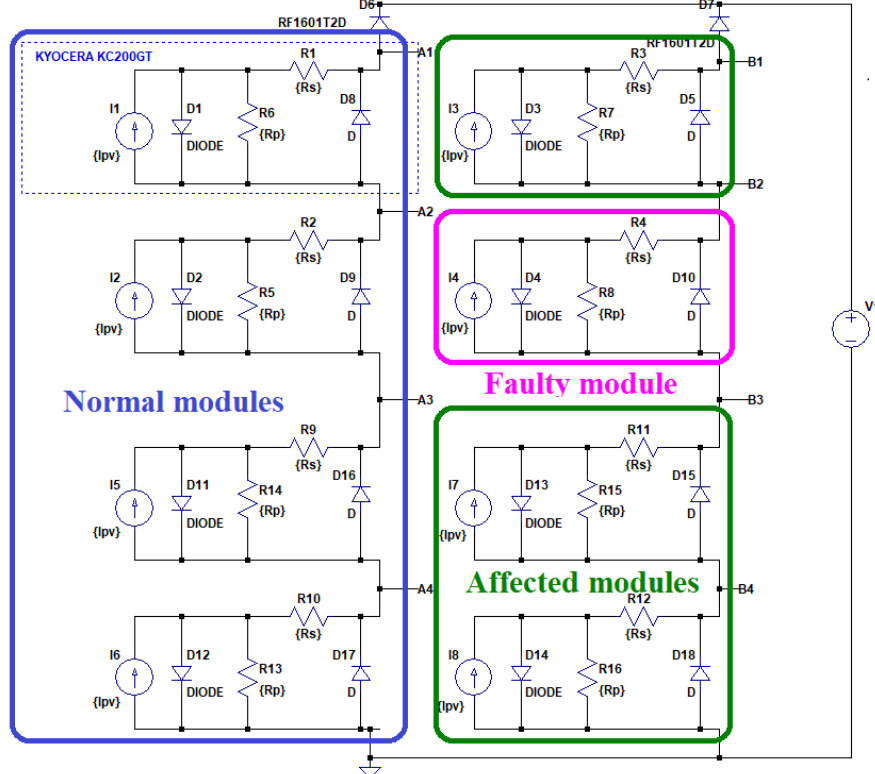
Figure 2. Circuit simulated in LtSpice software with seven types of faults.